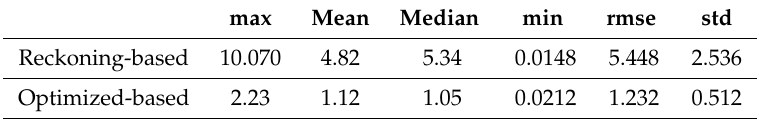
Figure 10. The evaluation of the resulting trajectories. ( a ) the data collecting path where the blue dot indicates the start and the red dot indicates the end. ( b ) comparison of the ground truth, the reckoning-based trajectory, and the optimized trajectory. ( c ) the absolute positioning error of the reckoning-based trajectory. ( d ) the absolute positioning error of the optimized trajectory. Table 2. The comparison of the absolute rose errors of trajectories in experiment I (in